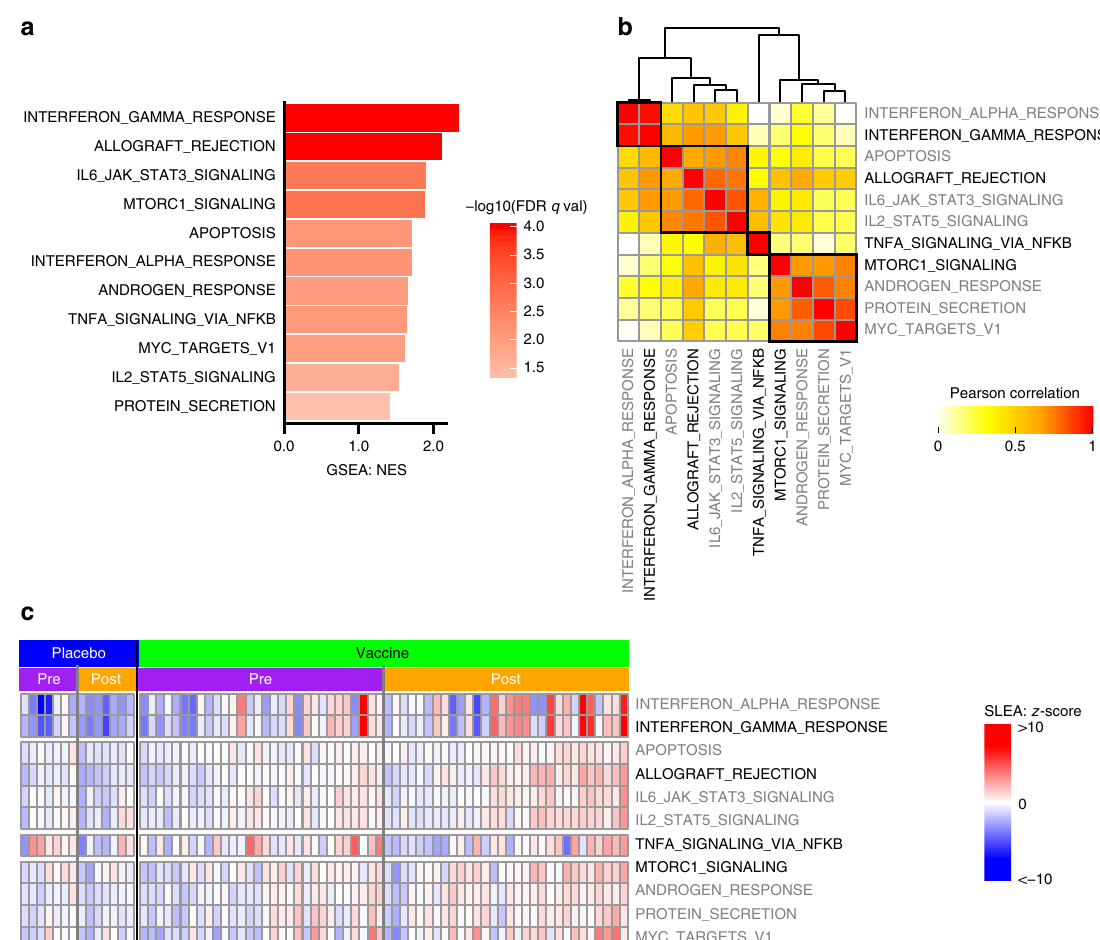
Fig. 2 IFN γ response is strongly induced by the in RV144 vaccine. a Barplot presenting the pathways modulated by the RV144 vaccine two weeks after the last immunization compared to preimmunization. A normalized enrichment score (NES) greater than 0 corresponds to a pathway for which member genes are upregulated in vaccinees. Eleven pathways were signi fi cantly modulated after immunization in RV144 vaccinees but not in placebo recipients (DB: Hallmark, GSEA: FDR ≤ 5%). b Sample-enrichment analysis (SLEA) of those 11 pathways followed by clustering revealed that those pathways could be separated into four groups of highly correlated pathways (indicated by the black boxes). The representative pathway of each of the four groups (the most signi fi cantly enriched) is indicated in black while the remaining pathways are labeled in gray. c Heatmap presenting the SLEA z -score of each of the 11 pathways among the 40 vaccinees and 10 placebo recipients included in the transcriptomic pilot study at both timepoints investigated (pre: prevaccination, post: 2 weeks after the last immunization). An SLEA z -score greater than 0 corresponds to a pathway for which member genes are up-regulated while an SLEA z -score inferior to 0 corresponds to a pathway with genes downregulated in that